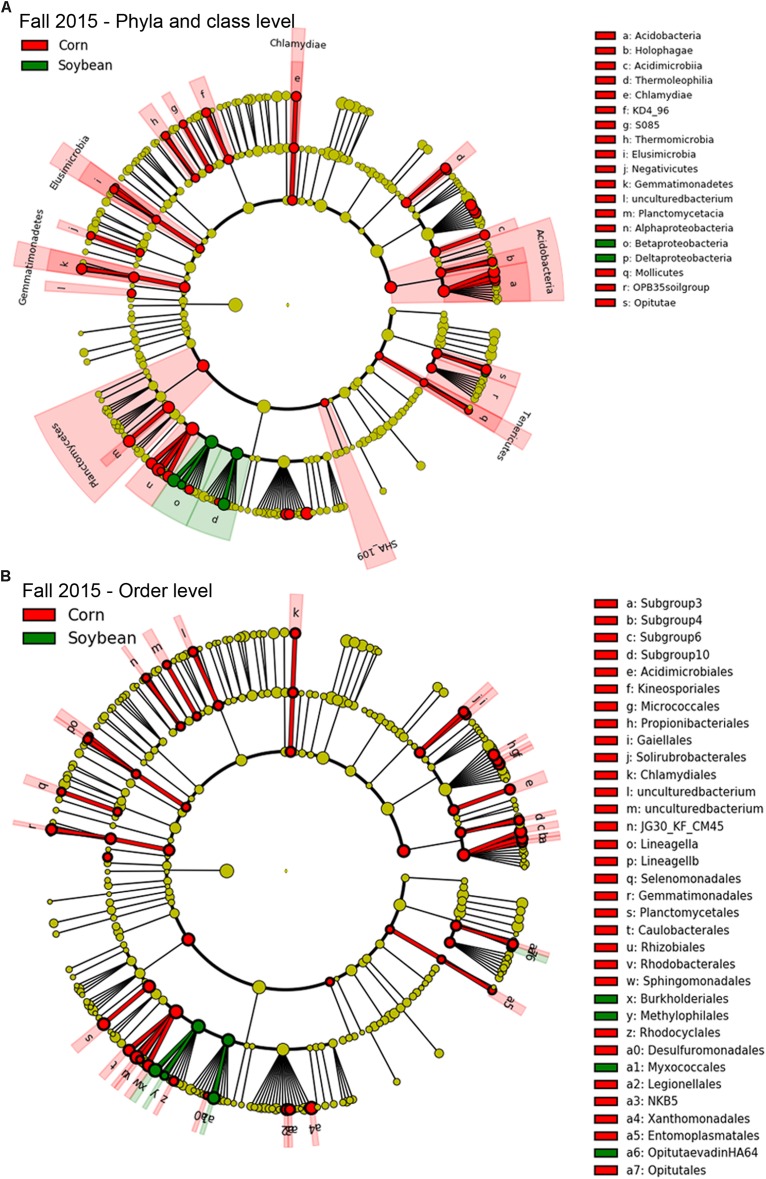
Taxa enriched in cysts of corn and soybean crop sequences identified by LEfSe analysis in fall of 2015. Cladograph shows taxa at different phylogenetic ranks that are significantly discriminant in cysts from soybean (green) and corn (red) crop sequences in fall 2015 at level of both bacterial (A) phyla and classes and (B) orders. The colored wedges indicate phyla/class and orders that are significantly discriminant at that phylogenetic rank. Letters code the specific classes or orders shown in the legend to the right. Smaller colored circles in each ring indicate significantly discriminant taxa at each lower taxonomic hierarchical level below phyum [e.g., order, family, genus, and species (OTU)] within bacterial classes. A full list of taxa used to generate this cladogram is given in Supplementary Table S6.